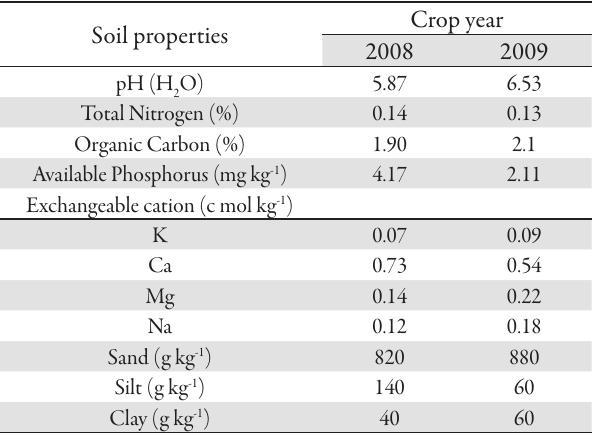
Tab. 1. Soil physical and chemical properties of the experimental site before cropping in both years